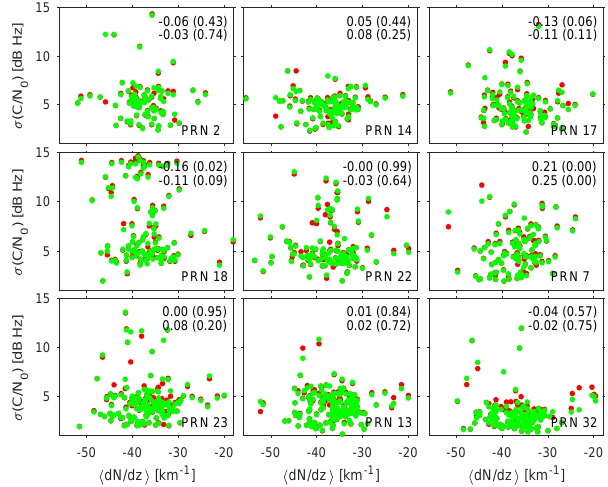
Figure 16. Same as Fig. 15 but the correlation analysis now in- cludes all observations at elevations between − 2 and + 2 ◦ . With the exception of PRN 7 (and the Pearson’s coefficient for PRN 18) the derived correlations are no longer significant. Note the change of scale with respect to Fig.